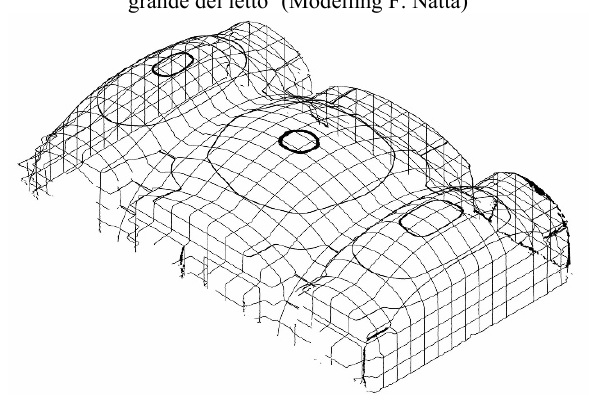
Figure 12. Figure 12. Solid model from 3DReshaper - ‘Camera grande del letto’ (Modelling F. Natta)